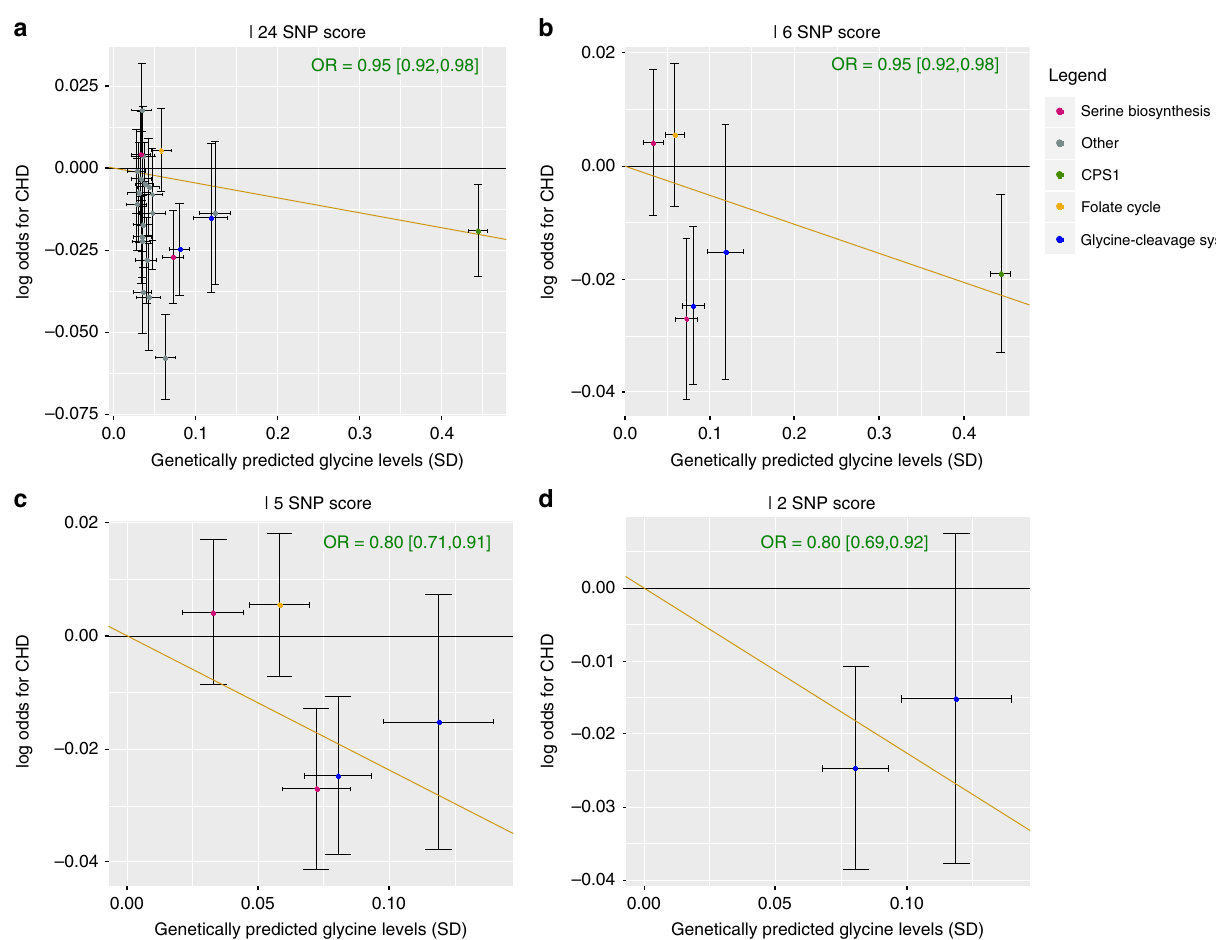
Fig. 5 Scatter plots of the effect sizes ± 95% con fi dence intervals of genetic variants for glycine on standard deviations of glycine levels versus the log odds for coronary heart disease. a For the 24 SNP score, b 6 SNP score, c 5 SNP score and d the 2 SNP score. The orange line represents the slope estimated using the weighted median